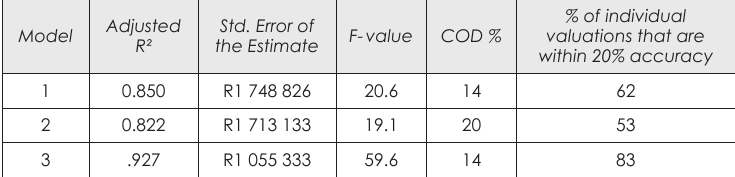
Table 11: Summary of the most important statistical